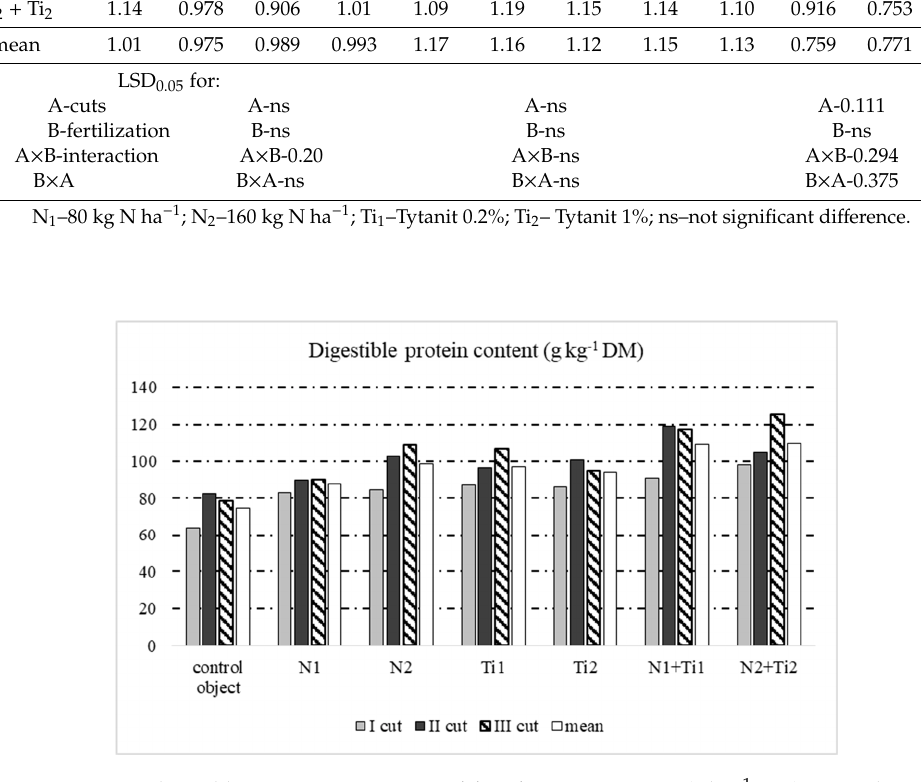
Figure 2. Average digestible protein content in Festulolium braunii across cuts (g . kg − 1 DM). N 1 –80 kg N ha − 1 ; N 2 –160 kg N ha − 1 ; Ti 1 –Tytanit 0.2%; Ti 2 –Tytanit 1%. LSD 0.05 for: A-2.31 (cuts); B-4.49 (treatment); A × B-6.10; B × A-7.78